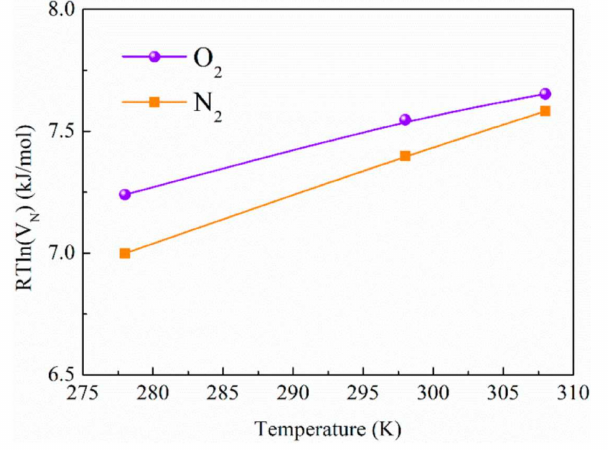
Figure 18. Linear dependence of RTln(V N ) vs. T for the adsorption of O 2 /N 2 . Reprinted with permission from [78] Copyright (2020)